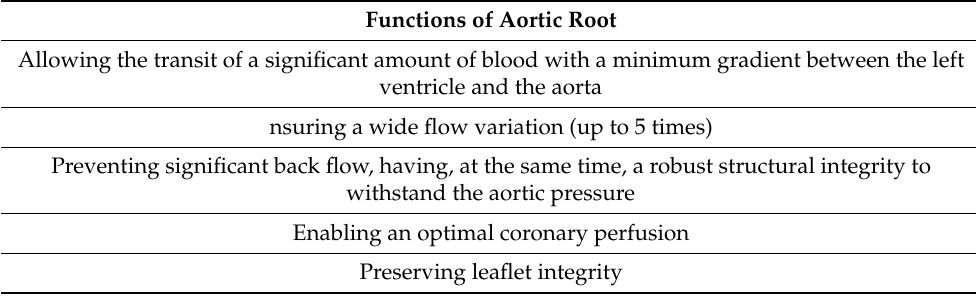
Table 2. Functions of the aortic